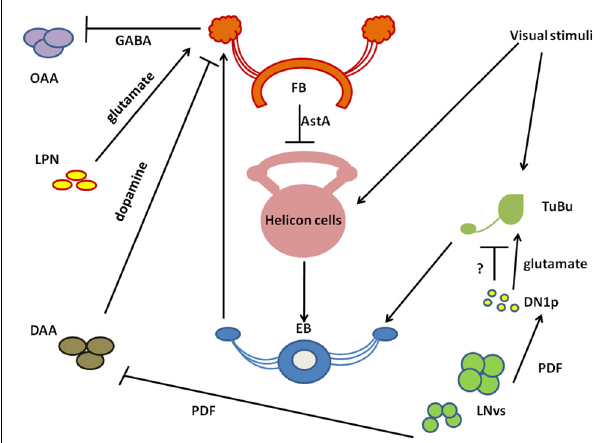
FIGURE 4 | A schematized and simplified circuit showing how light perceived by retinal and extra-retinal structures impacts sleep. Light-activated retinal photoreceptors release histamine (His). Mutations affecting the histamine biosynthesis pathway ( hdc mutants) lead to increase in sleep. R1–R6 photoreceptors convey signals to cholinergic large monopolar laminar cells (L2) that connect indirectly both clock neurons (l-LNvs) and neurons involved in motion pathways (T5). Temperature-Sensing TRP Channel activation in L2 neurons strongly suppresses sleep by releasing ACh that, in turn, promotes the bursting of l-LNvs. T5 cells axons transfer motion information to various types of lobula plate tangential neurons (LPTCs), like HS (horizontal